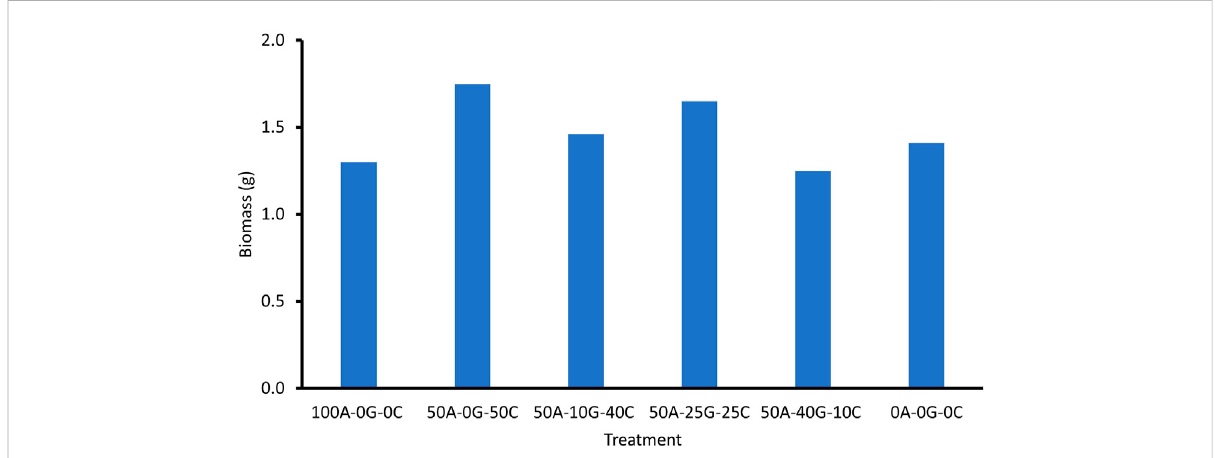
FIGURE 3 Effect of treatment group on biomass. 100A-0G-0C (Positive control) — 100% sodium alginate, 0% glomalin, 0% Chlorella vulgaris 50A-0G- 50C — 50% sodium alginate, 0% glomalin, 50% Chlorella vulgaris 50A-10G-40C — 50% sodium alginate, 10% glomalin, 40% Chlorella vulgaris